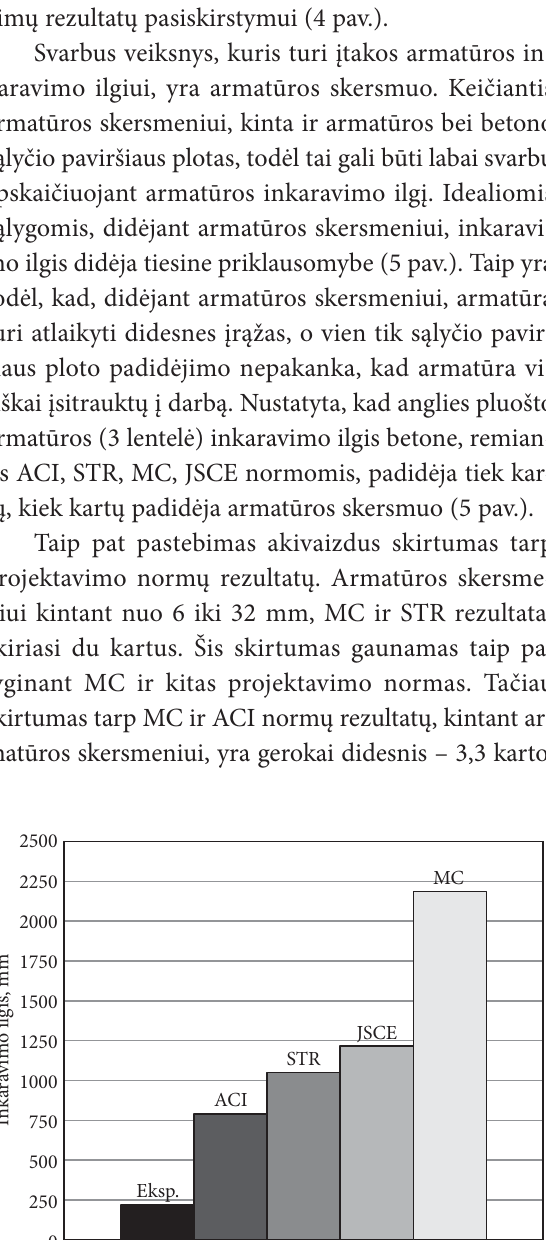
Table 1. Mechanical properties of concrete and reinforcement